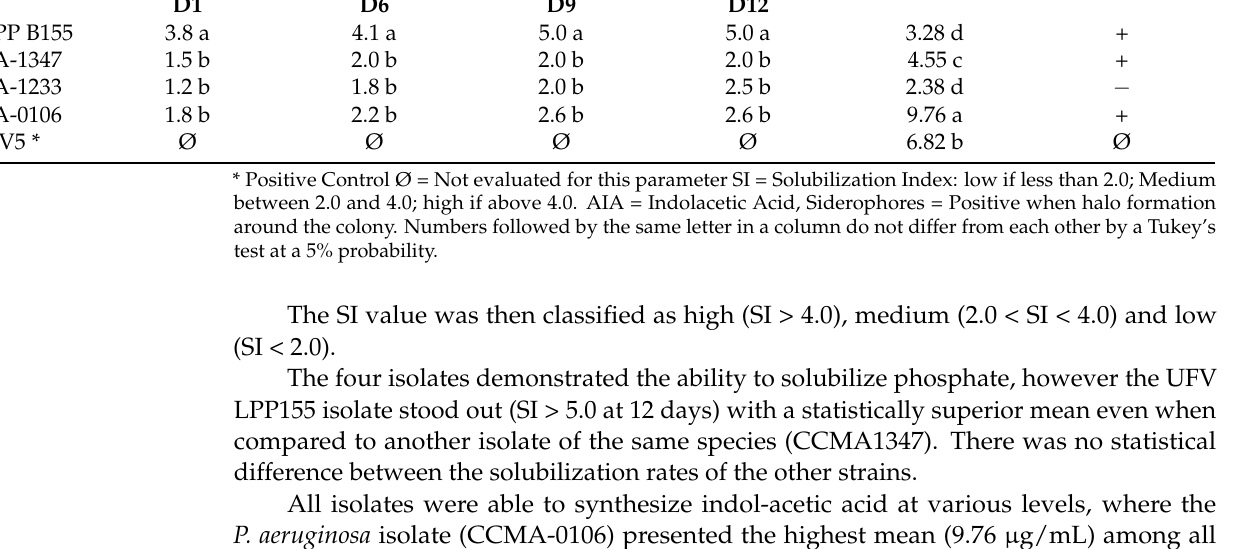
Table 3. Phosphate solubilization, auxin, and siderophores production of the tested isolates. Microorganism P Solubilization (SI) AIA ( µ g/mL) Siderophores